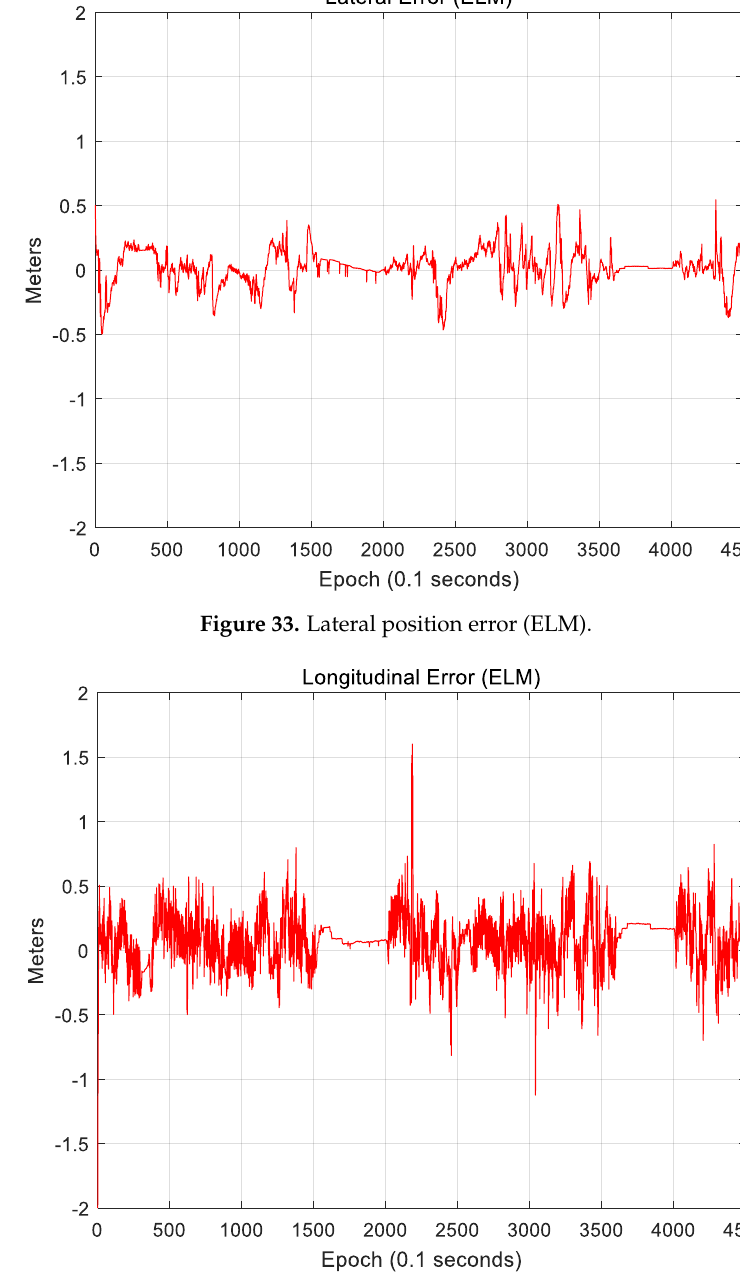
Figure 34. Longitudinal position error (ELM).